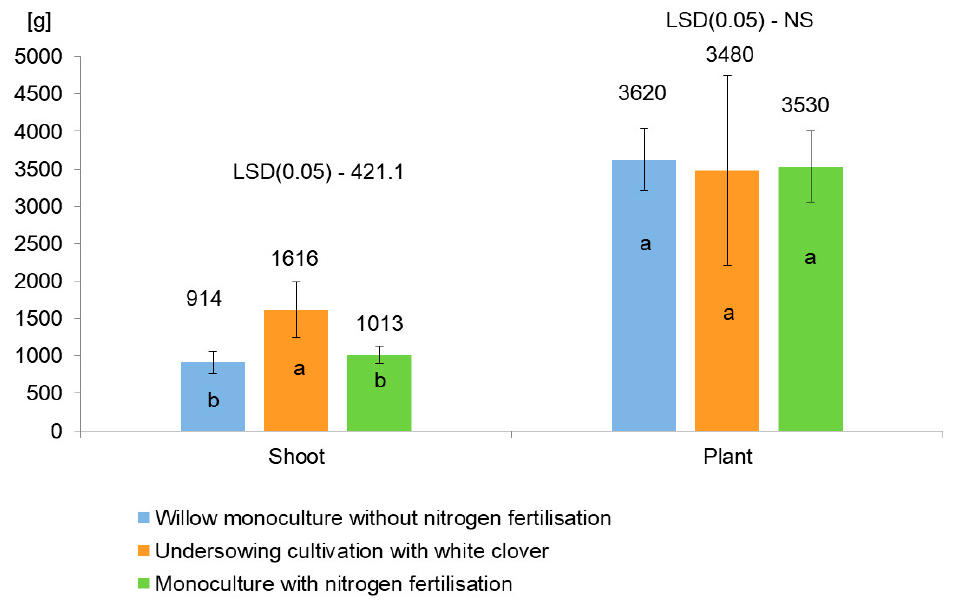
Figure 1. Influence of undersowing cultivation and nitrogen fertilization on the dry mass of 1 shoot and plants of willow plants after harvest in December 2017. LSD—the least significant difference. NS—difference is not significant. Different letters indicate significant differences between treatments (Tukey’s multiple range test).